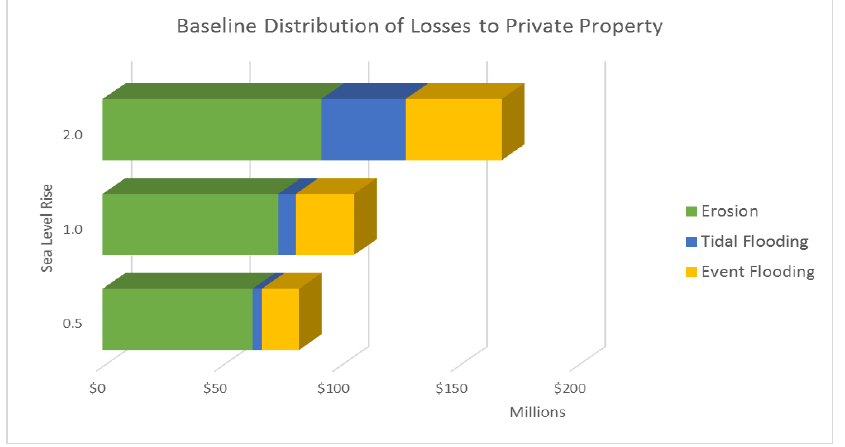
Figure 7. Losses and damages for private development from each of the coastal hazards through time.